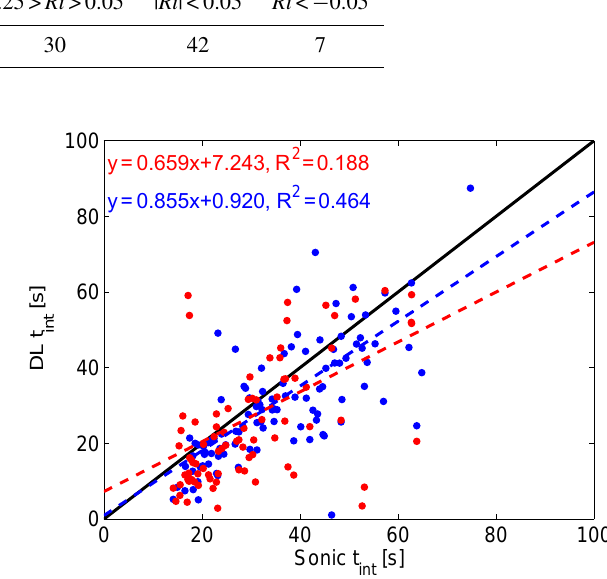
Figure 3. Comparison of t int as calculated from the sonic anemome- ter and DL M 11 values, using Eq. (9). Red shows values calculated from LLNL WC measurements and blue shows those calculated from the OU DL observations. Black solid line shows a one-to- one relationship. The dashed lines show the linear regressions, with the equations for linear regression and coefficients of determination shown in the upper-left